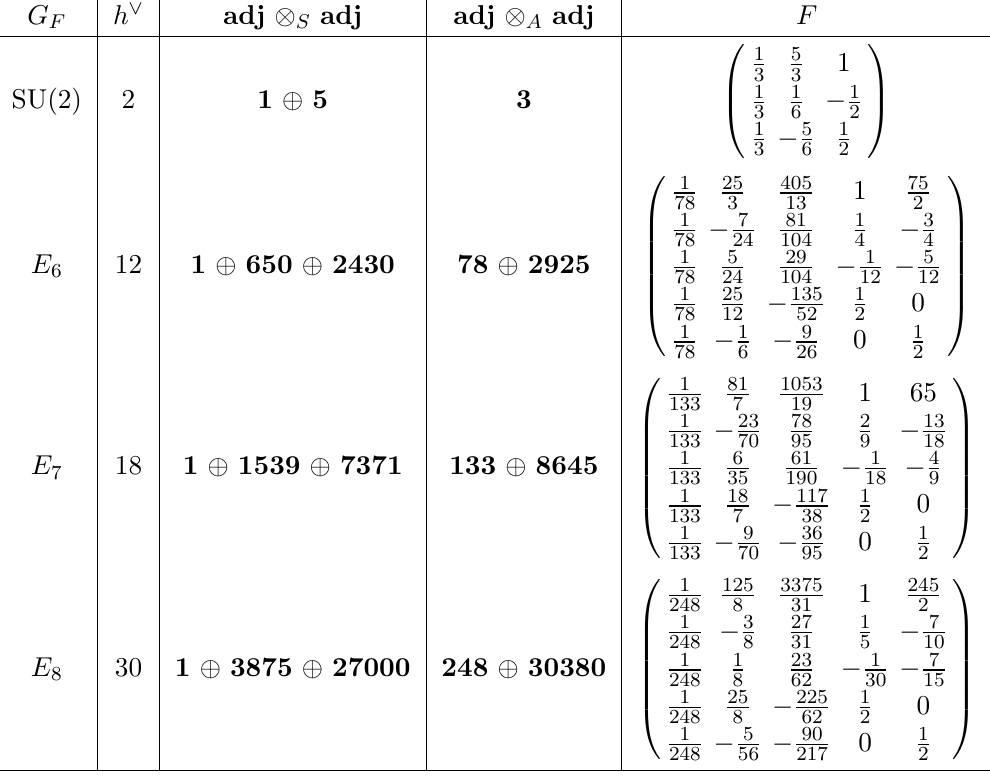
Table 6. The crossing matrices for adj (cid:10) adj of SU(2), E 6 , E 7 , and E 8 (cid:13)avor groups. The basis for the crossing matrices are in the order as shown in the adj (cid:10) S adj and adj (cid:10) A adj